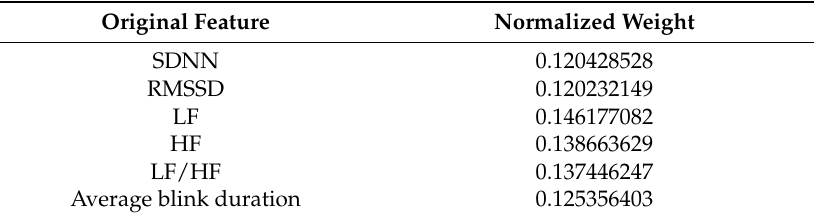
Table 4. Normalized weight of original feature.